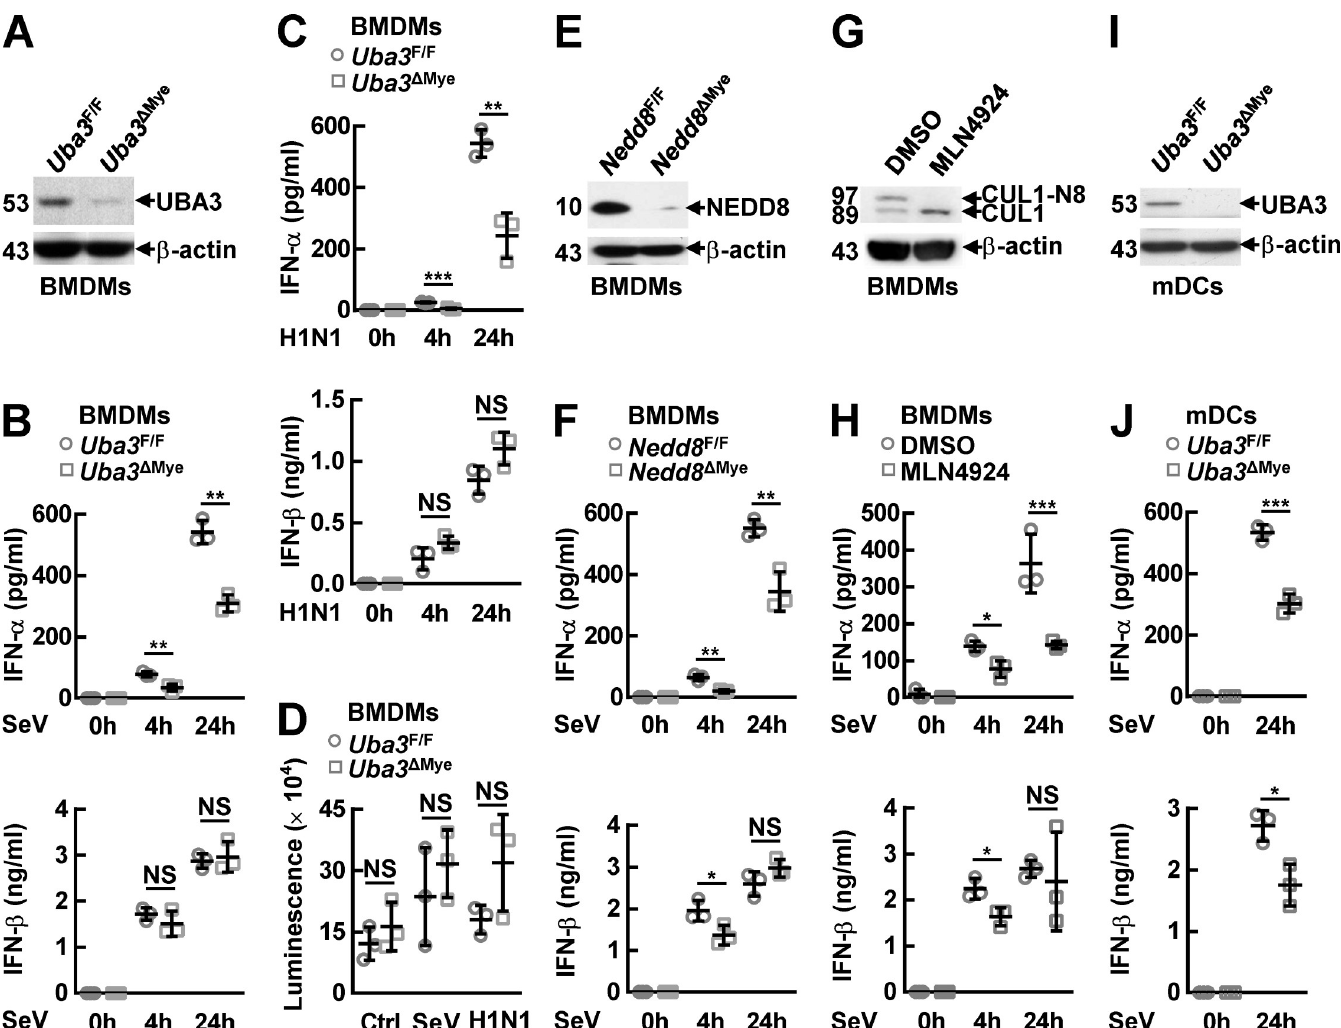
Fig 1. Neddylation promotes RNA virus-induced IFN- α production in myeloid cells. (A-F, I, J) BMDMs or mDCs were cultured from the indicated mouse models. After immunoblotting (IB) analysis with the indicated antibodies to confirm the deficiency of UBA3 (A, I) or NEDD8 (E), these myeloid cells were infected with the indicated RNA viruses for the indicated time periods. Then the supernatants were subjected to ELISA (B, C, F, J). The survival of UBA3-deficient BMDMs before and 24 h after RNA virus infection was measured by ATP lite assays (D). (G) IB analysis to confirm the efficiency of MLN4924 pretreatment (0.1 μ M, 3 h) in wild type (WT) BMDMs. (H) After MLN4924 pretreatment (0.1 μ M, 3 h), WT BMDMs were infected with SeV for the indicated time periods. Then the supernatants were subjected to ELISA. Quantitative data are shown as Mean ± SD ( n = 3 per group). � p < 0.05; �� p < 0.01; ��� p < 0.001; NS, not significant. CUL-N8, neddylated Cullin